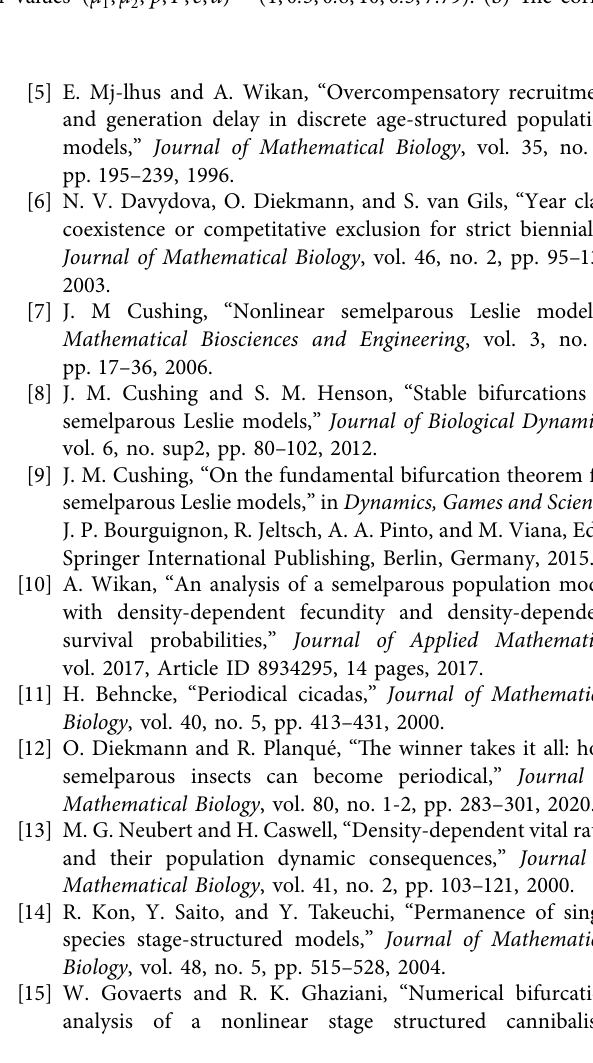
, μ , p,F,c, a ) � ( 1 , 0 . 5 , 0 . 8 , 10 , 0 . 5 , 7 . 79 ) . (b) Te corre- 1 2